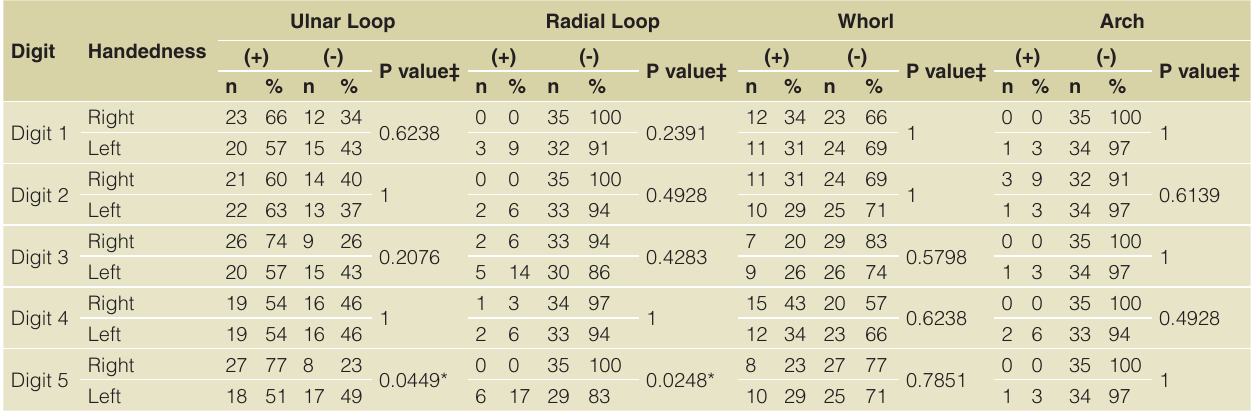
‡ = Two sided fishers exact test, * P=<0.05